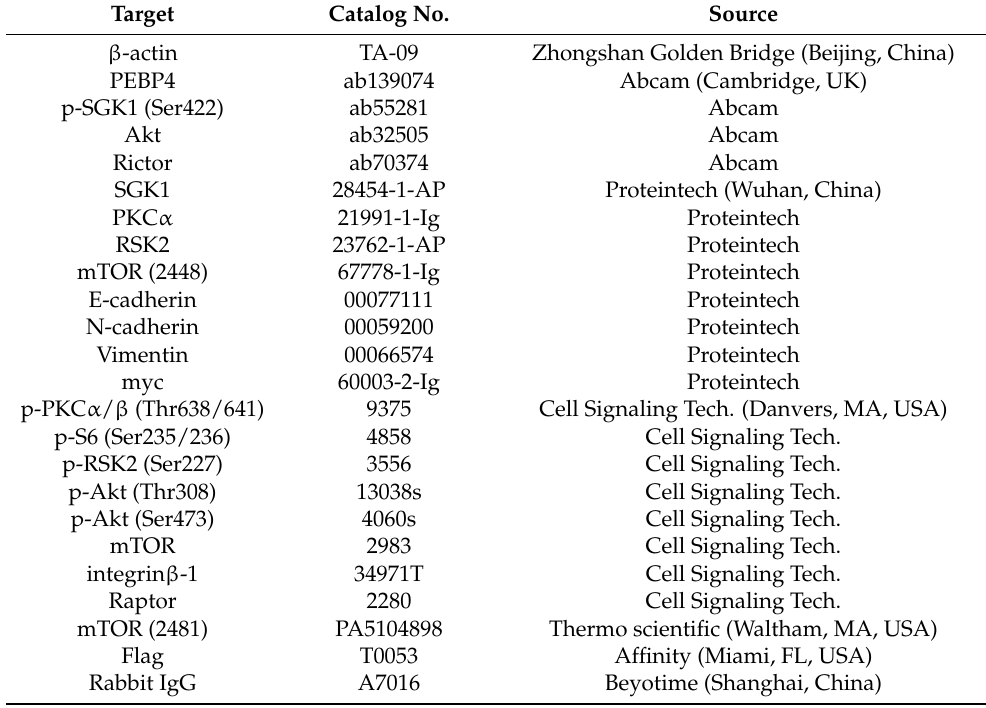
Table 1. List of antibodies used in this article.